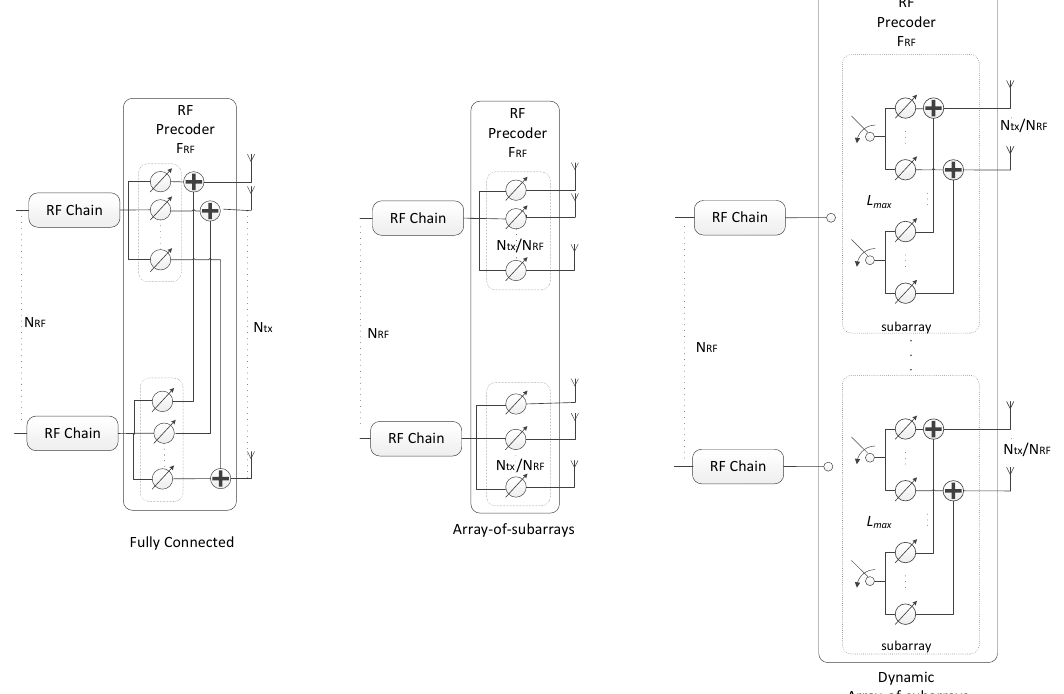
Sensors 2021 , 21 , x FOR PEER REVIEW Figure 2. Different precoder architectures for a mmWave/THz MIMO system based on phase shifters.